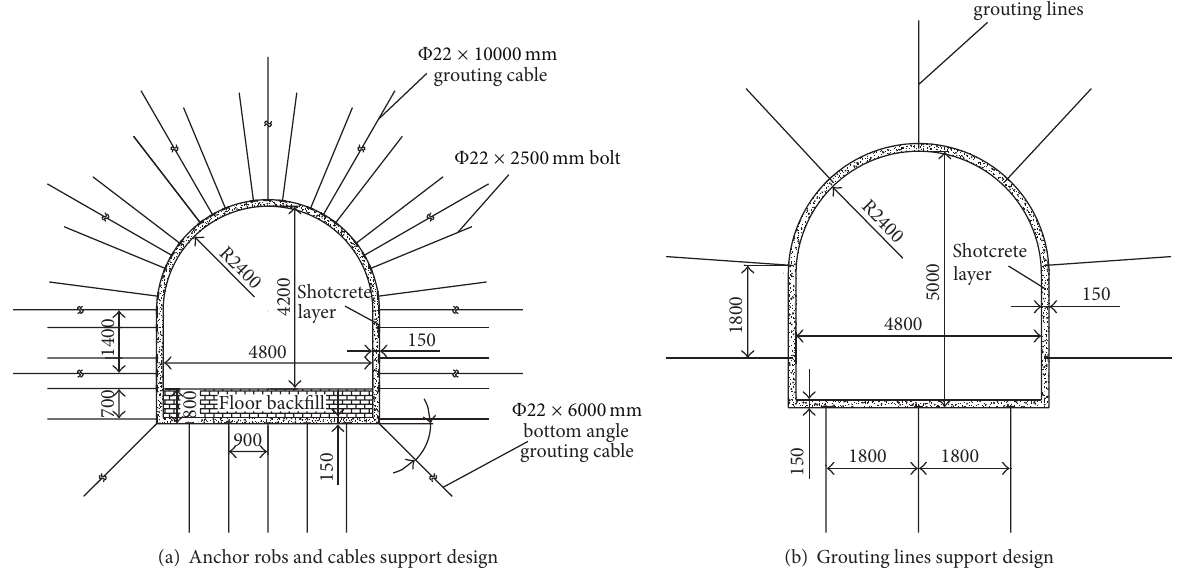
Figure 10: New supporting design of the roadway.